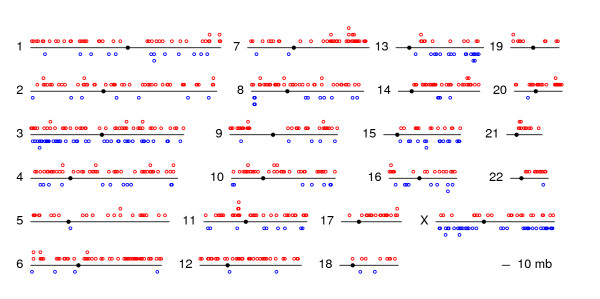
Distribution of HDIs and LDIs. Genomic distribution of HDIs (red) and LDIs (blue). Chromosomes are represented by lines with a filled circle at the centromere. Each circle represents a significant genomic island, as identified by a Hidden Markov Model.